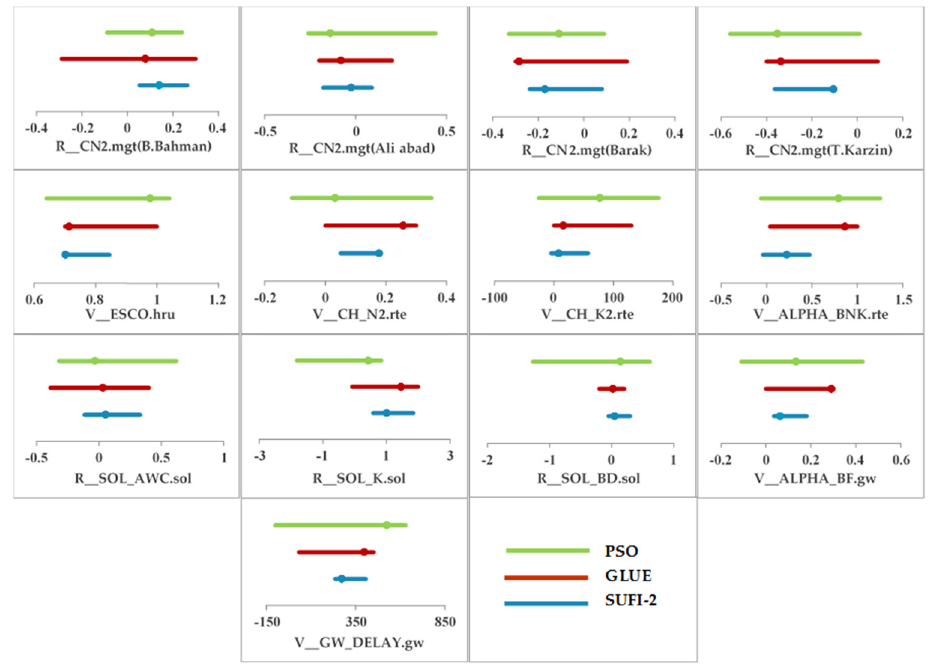
Figure 7. Uncertainty ranges of the parameters based on all three methods applied in Salman Dam Basin (SDB). The points in each line show the best value of the parameters, r_ refers to a relative change where the current values are multiplied by one plus a factor from the given parameter range, and v_ refers to the substitution by a value from the given parameter range [24]).